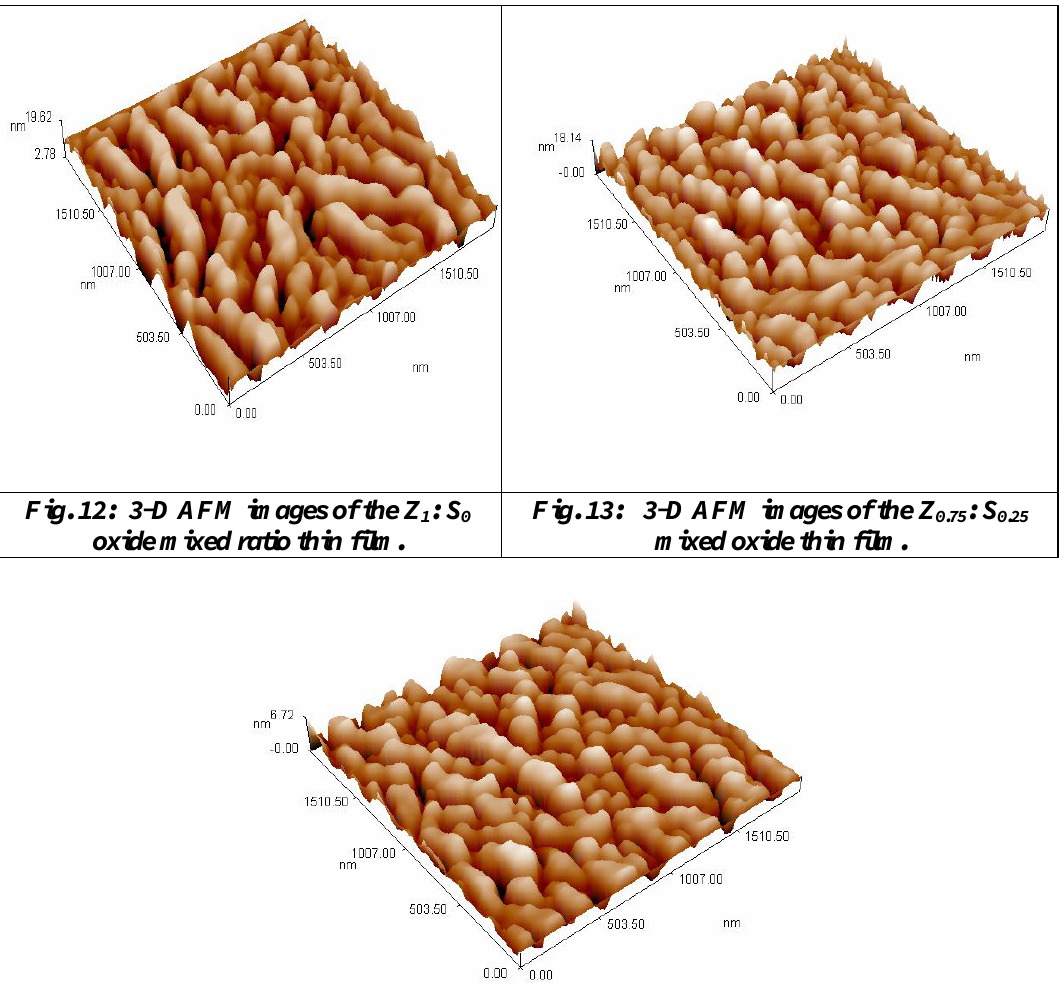
Fig. 14: 3-D AFM images of the Z